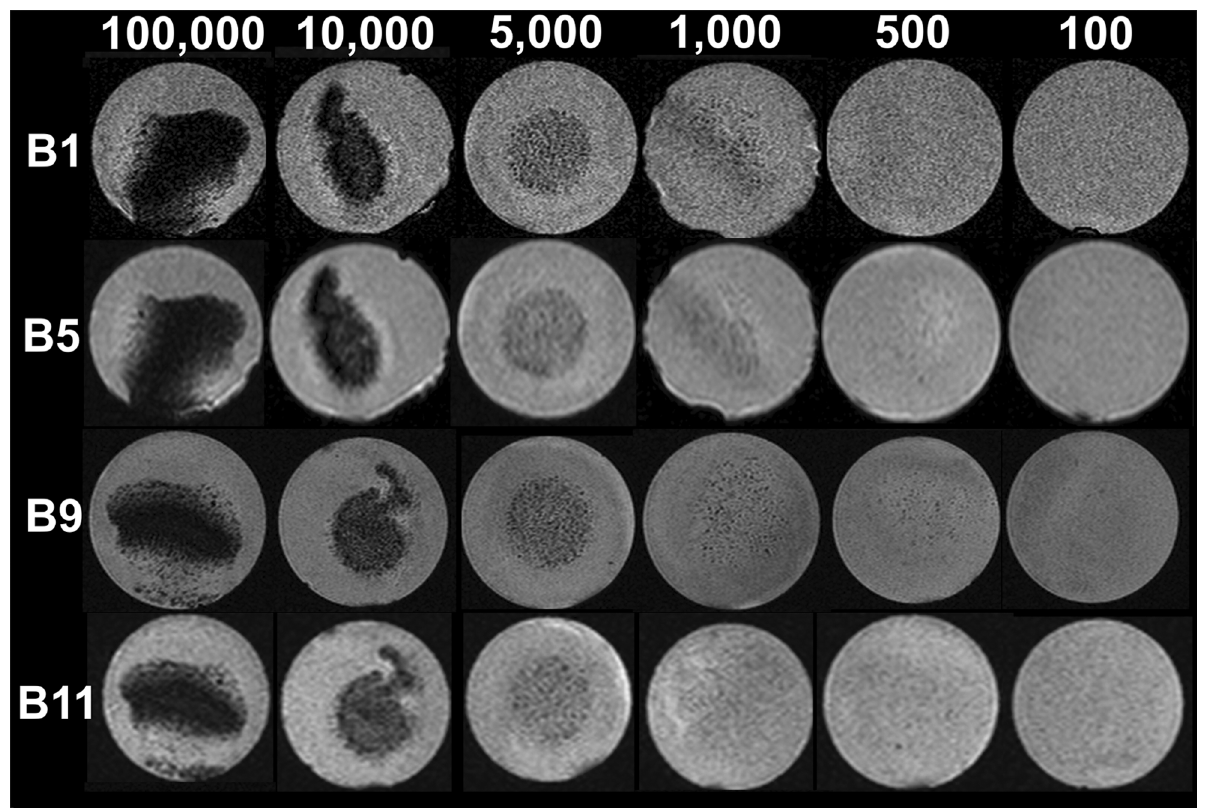
Figure 5. Representative phantom MR images for evaluation of the detection limit, images of Group B. Cross sectional images of results from group B at different cell concentrations and with different pulse sequences. The cell concentrations are indicated in the top row, the pulse sequences are indicated on the left according to Table 1. A diffuse signal loss at a concentration of 500 cells can be seen in B9. In B11 the signal loss at 500 cells is not obvious at inspection. Both sequences were rated sensitive for a concentration of 500 cells by ROI analysis. The higher resolution of B9 can be easily identified. The main differences between these sequences are in-plane resolution and the averages, and therefore the scanning time. Comparing B9 and B1 (8 channel knee coil and 12 channel head coil) B1 appears to be noisier although the imaging parameters remain the same. In some slices an apparently irregular shape of the container can be noted. This is due to small air inclusions at the side of the gel bloc that result in signal voids melting with the black background. The actual form, size and material of the container was the same in all